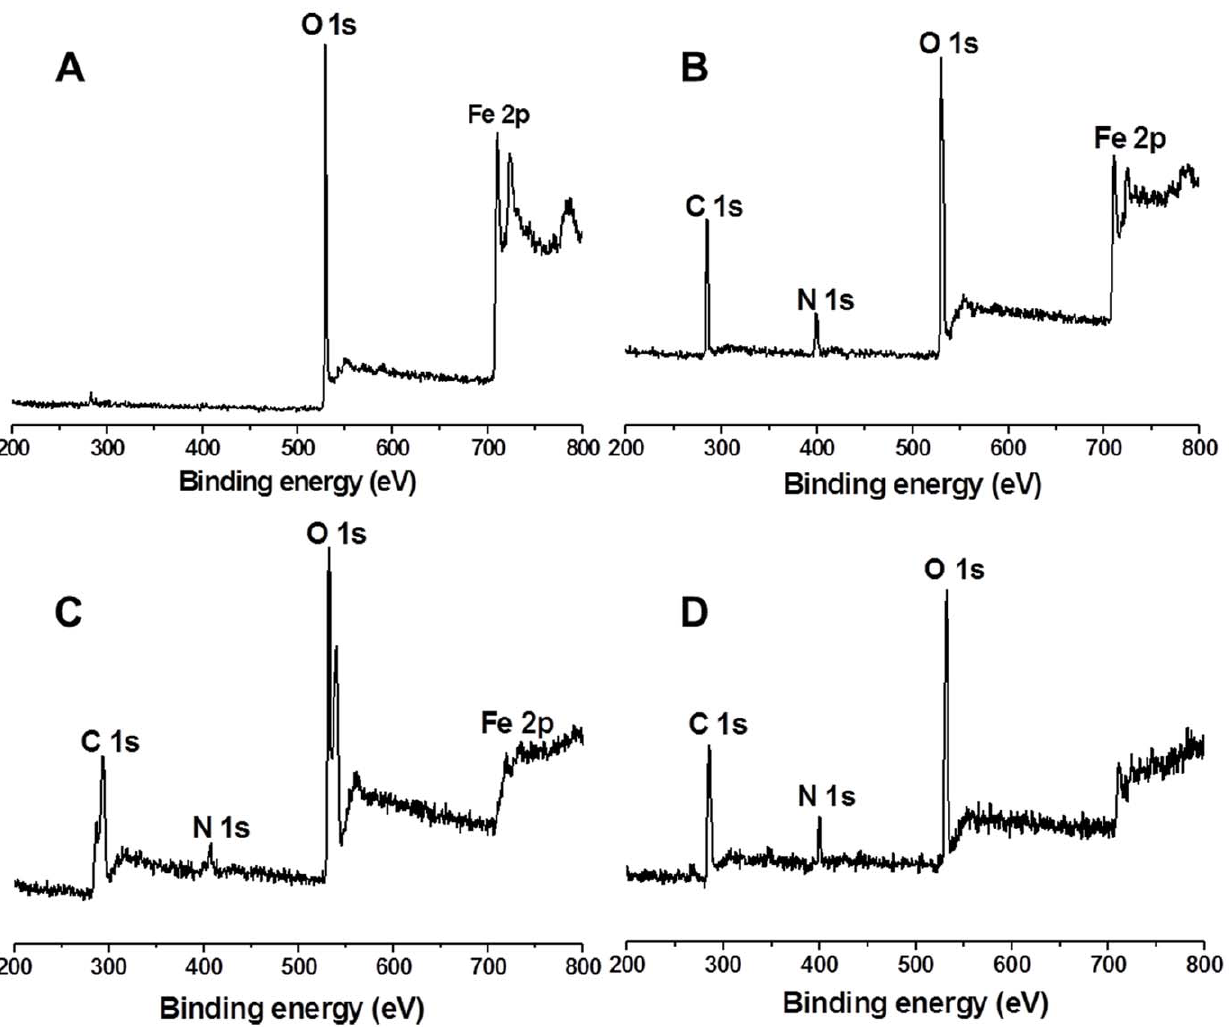
Figure 2. XPS spectra. XPS spectra of particles A: the IONPs; B: the CS-IONPs composites; C: the adhesive CCS-IONPs composites; D: the adhesive CCS-IONPs composites after enzyme immobilized.